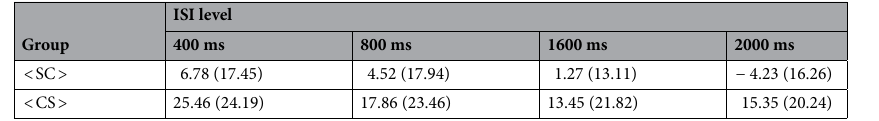
Table 6. Constant errors (CEs). Mean CE values and SDs for each group and each ISI level. CEs were larger for the < CS > than for the < SC > group. However, for both groups the CE decreases as the ISI increases, with exception of the ISI 2000 condition of the < CS >